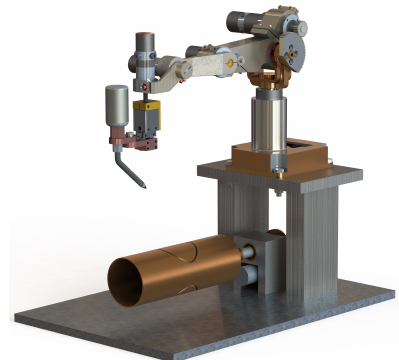
Fig. 6: The 3D system of Robot.